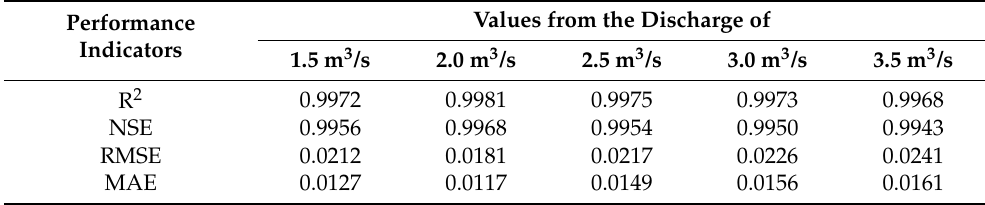
Table 6. Performance indicators of the sediment simulation results.